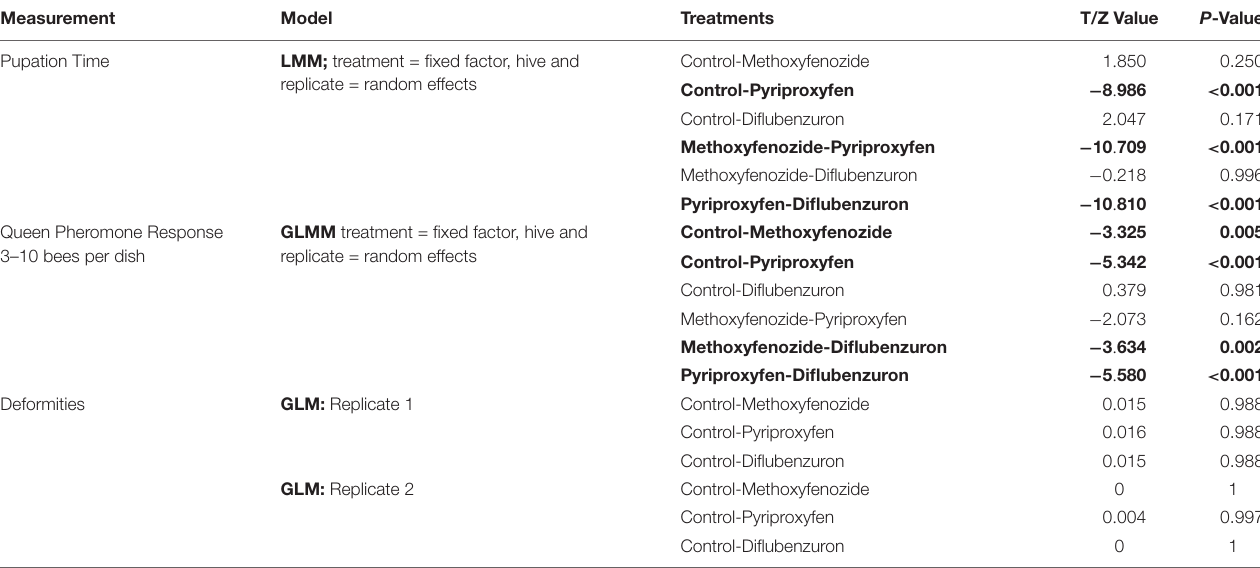
TABLE 1 | Results of statistical analysis of pupation time, QP response per bee and rate of deformities in eclosing Apis mellifera adults following developmental exposure to IGDs. Measurement Pupation